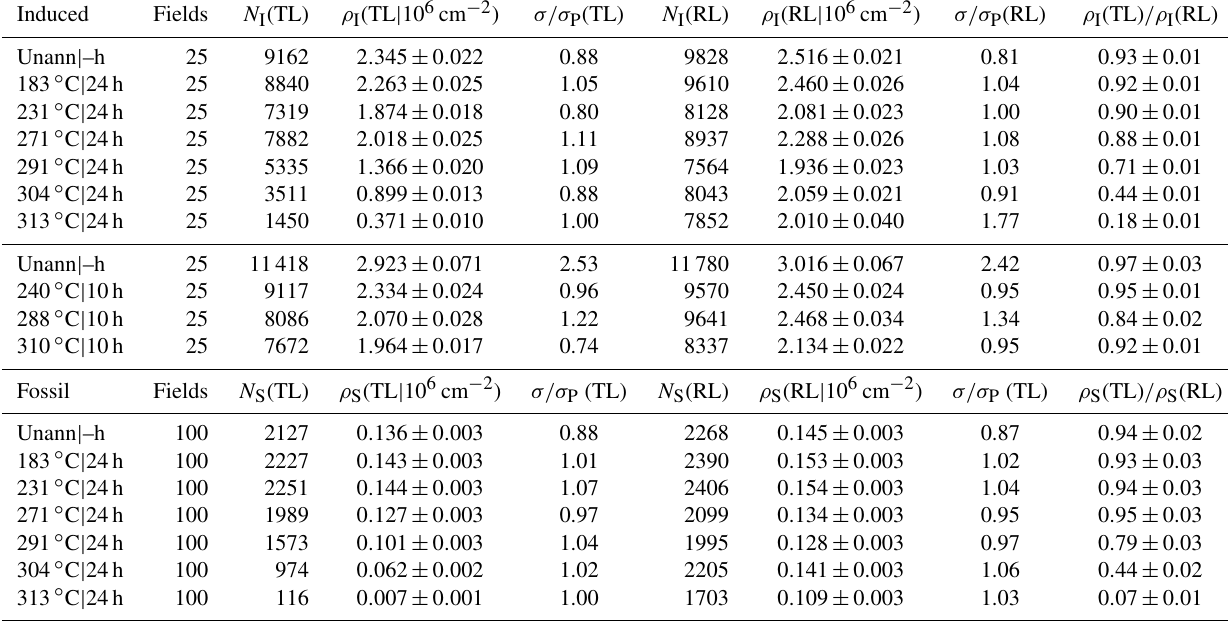
Table 2. Transmitted-light (TL) and reflected-light (RL) counts of induced and fossil tracks in annealed prism sections of Durango apatite. Detailed data in the Supplement file